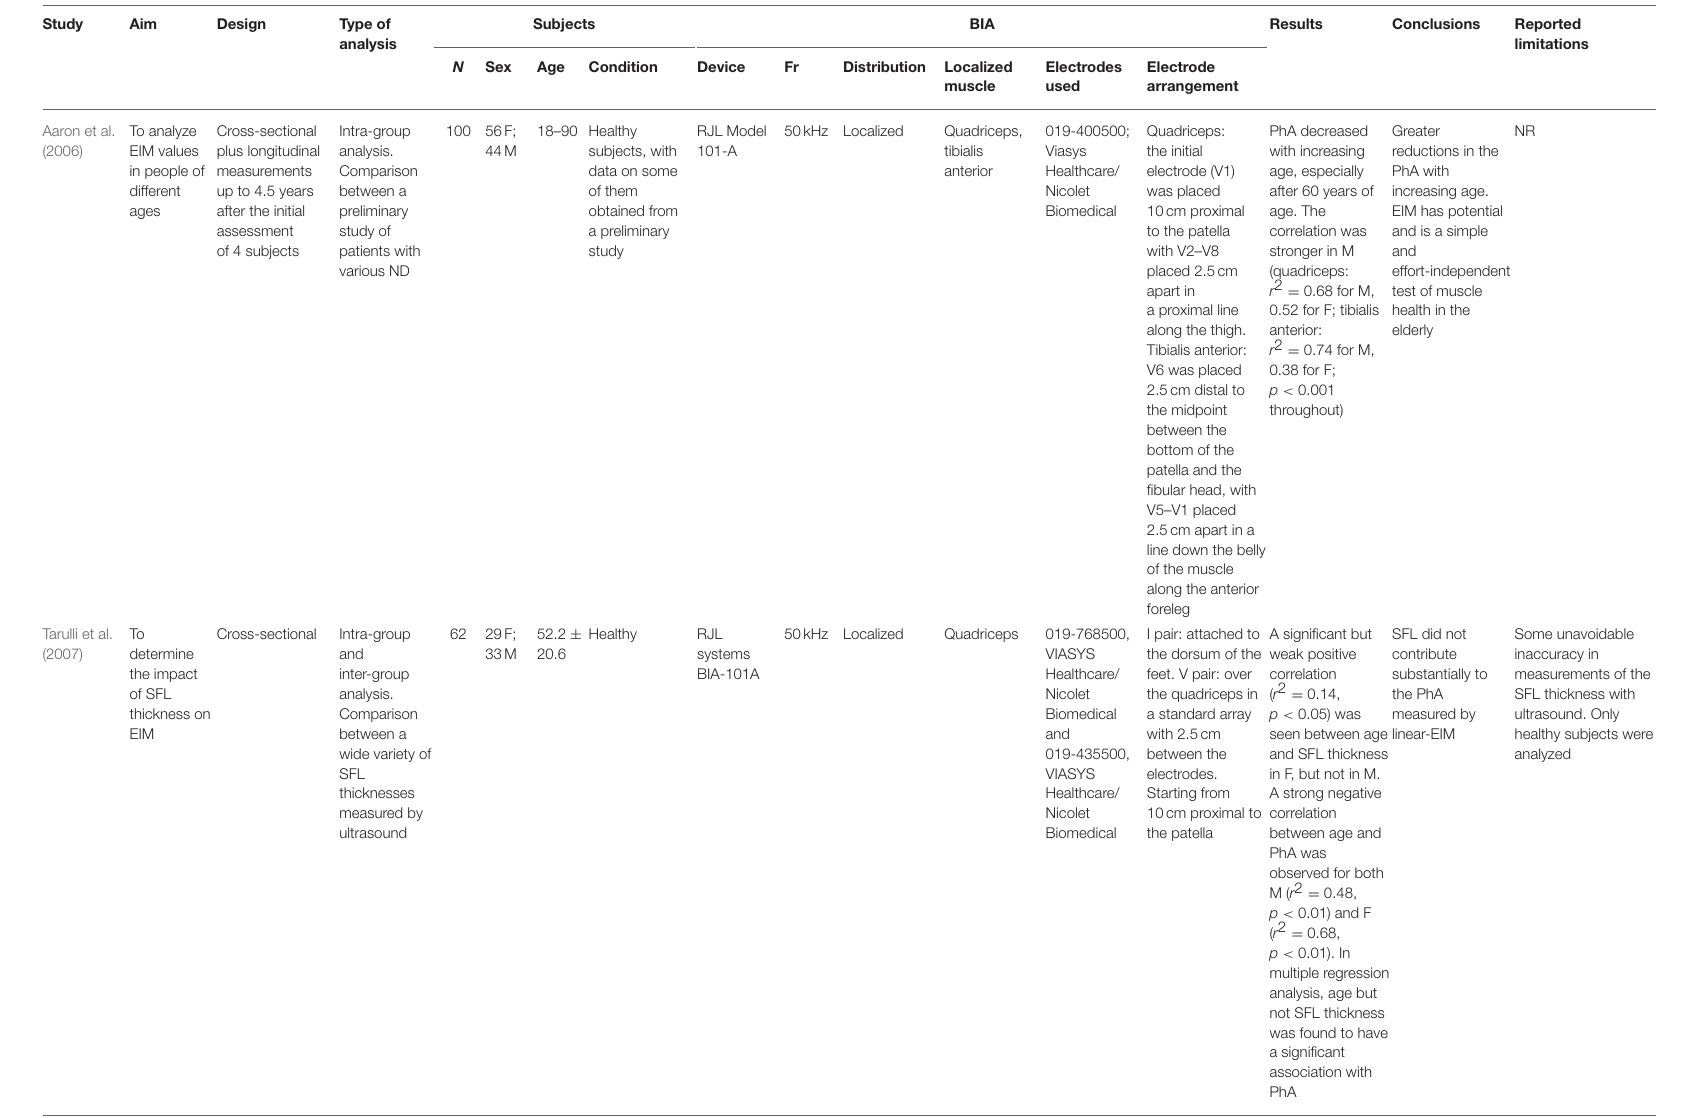
TABLE 1 | Reviewed EIM studies on the bioelectrical characterization of